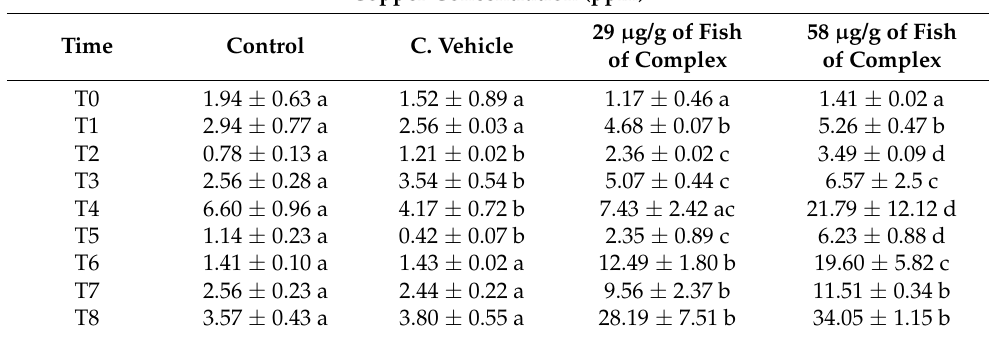
Table 1. Copper concentration in pond water at different times during feeding with [Cu(NN1) 2 ](ClO 4 ) complex. Different letters mean statistically significant differences between treatments. Statistical analyses were independently carried out at each time analyzed. Statistically significant differences were determined compared to the control by a one-way nonparametric t -test (Mann–Whitney) ( p < 0.05). Copper Concentration (ppm) 29 µ g/g of Fish 58 µ g/g of Time Control C. Vehicle